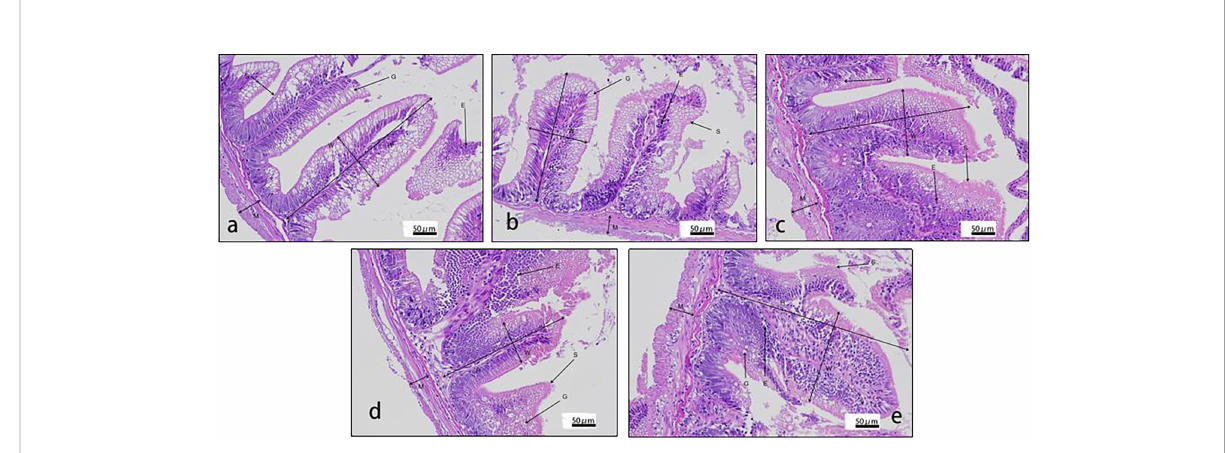
FIGURE 2 Histology of distal intestine in rainbow trout fed graded cottonseed protein concentrate. (A) FM; (B) CPC25%; (C) CPC50%; (D) CPC75%; (E) CPC100%. W-villus width, H-villus height, M-muscular layer thickness, S-striatum; G-goblet cells and E-epithelial cells.